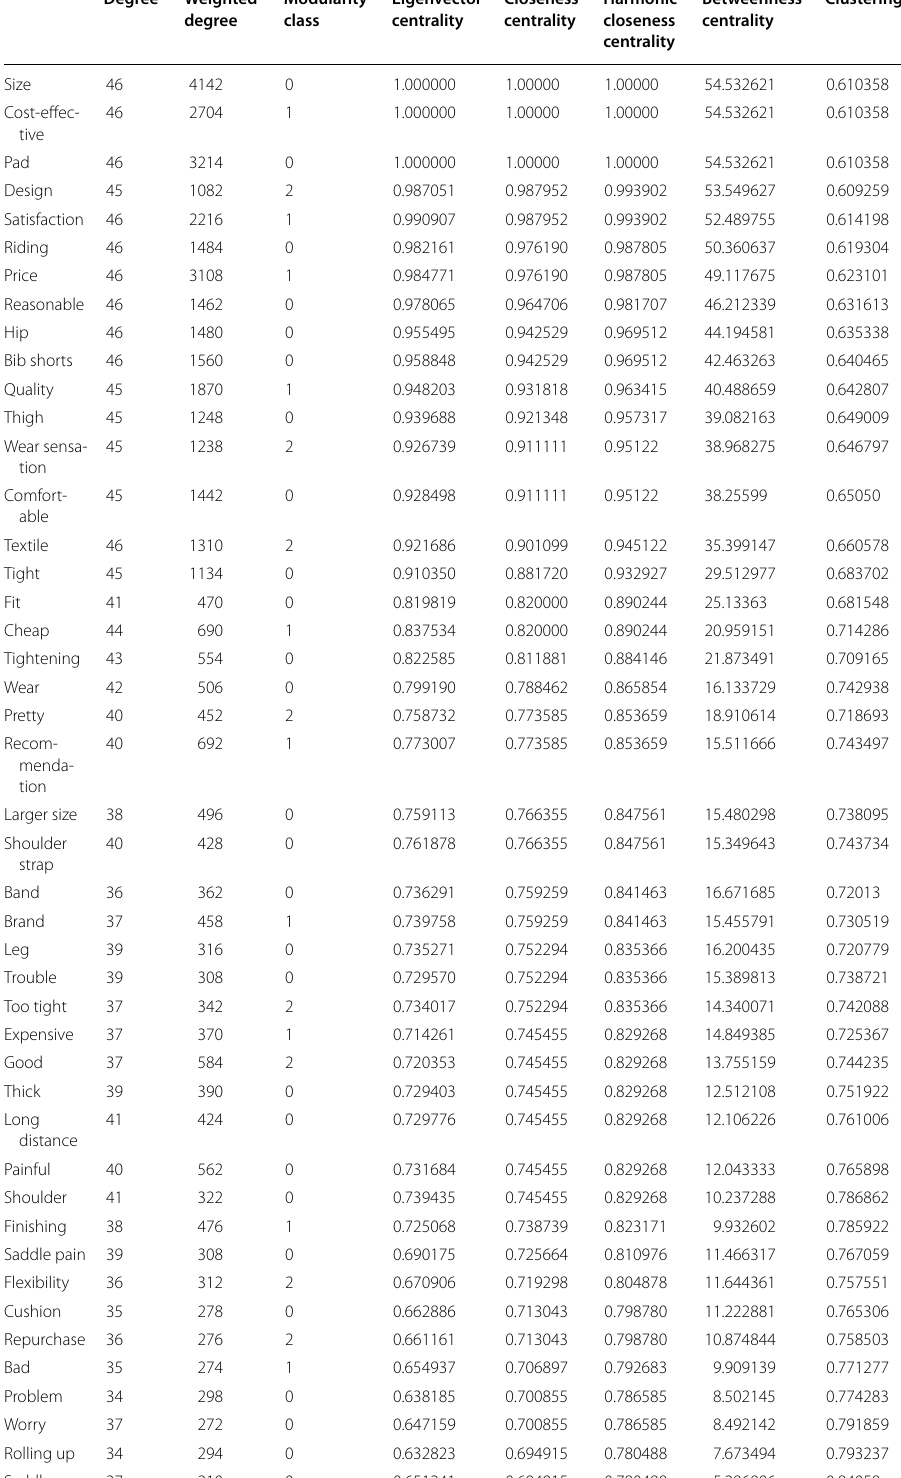
Table 7 Network analysis according to co-occurrence